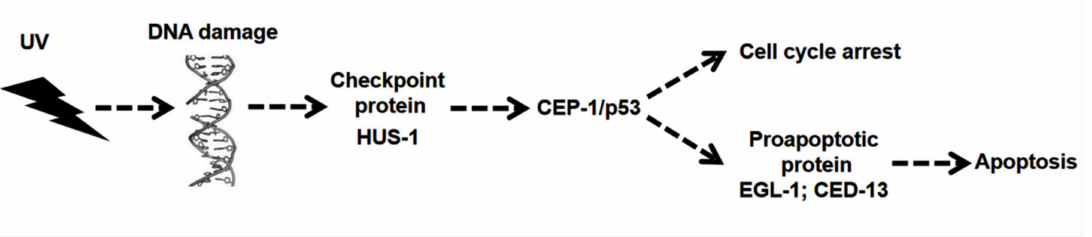
Figure 1. UV-induced apoptosis pathway in C. elegans